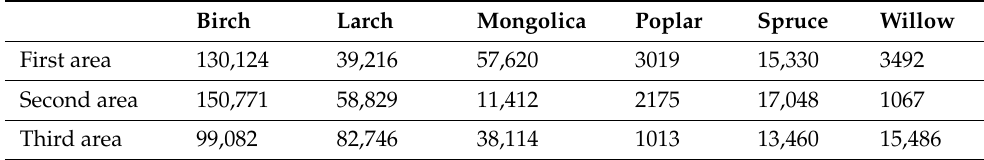
Table 1. List of 6 tree species samples of the three study